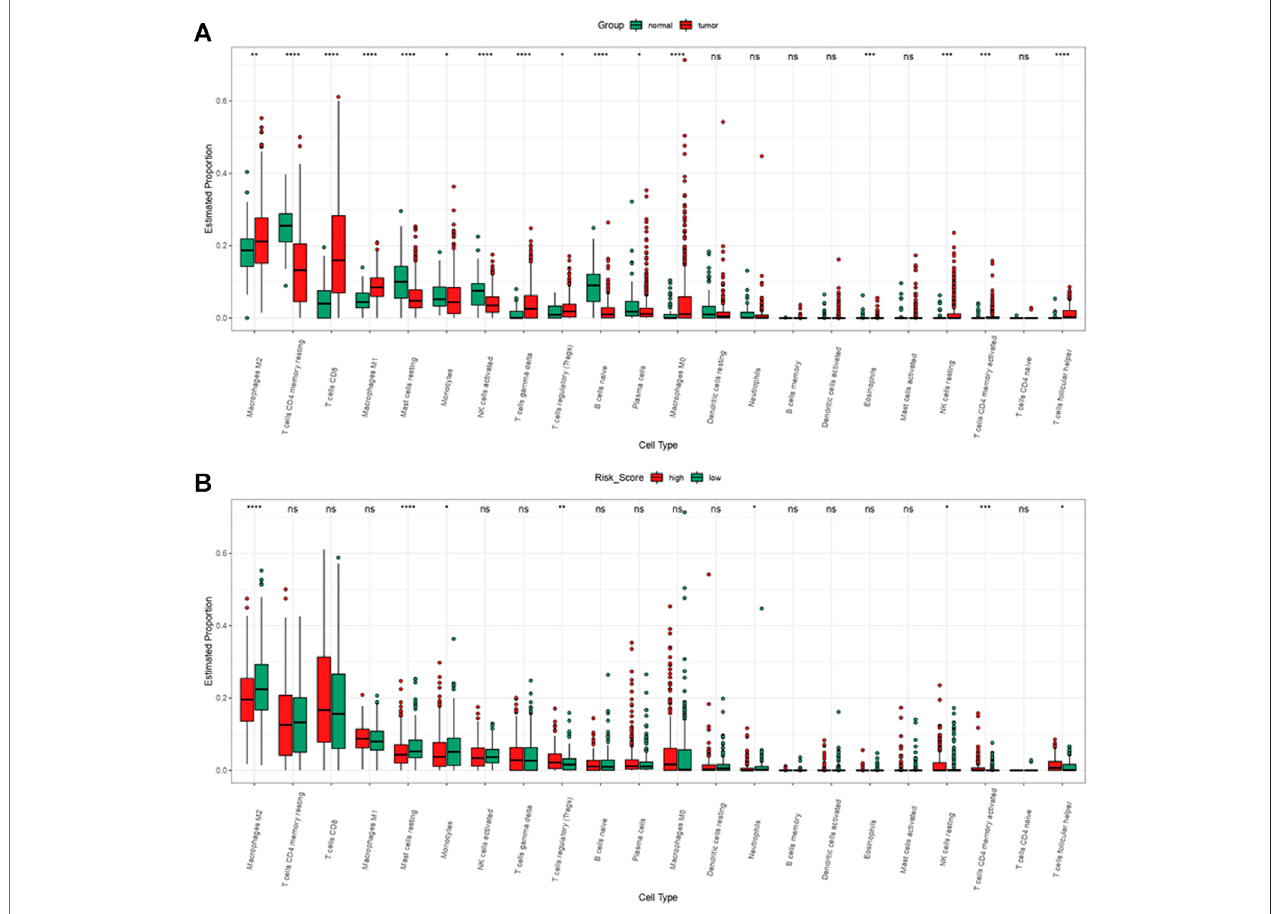
FIGURE 14 | Immune cell in fi ltration of ccRCC patients from TCGA-KIRC dataset. (A) Immune cell in fi ltration levels in ccRCC and normal tissue. (B) Immune cell in fi ltration levels of high and low risk